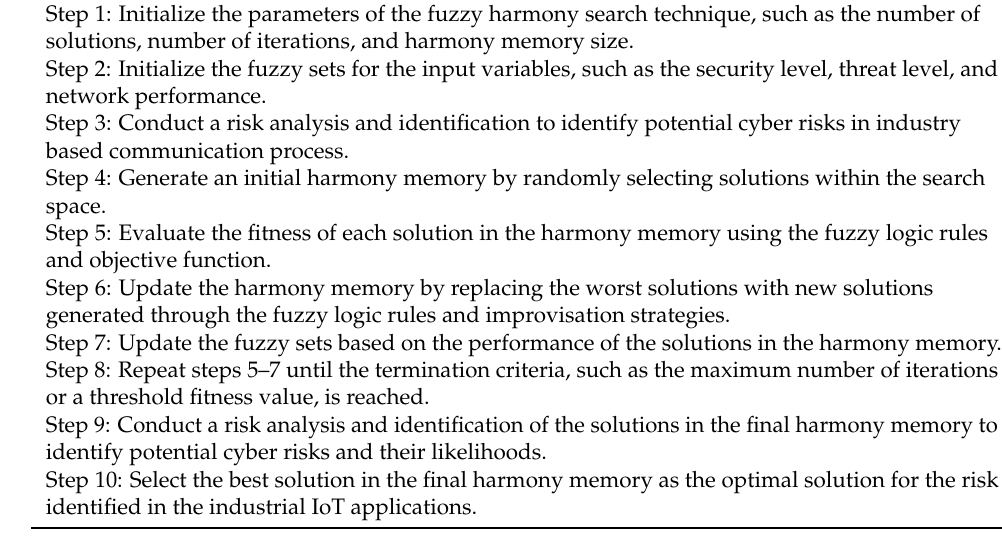
Table 1. Fuzzy harmony search based risk identification.